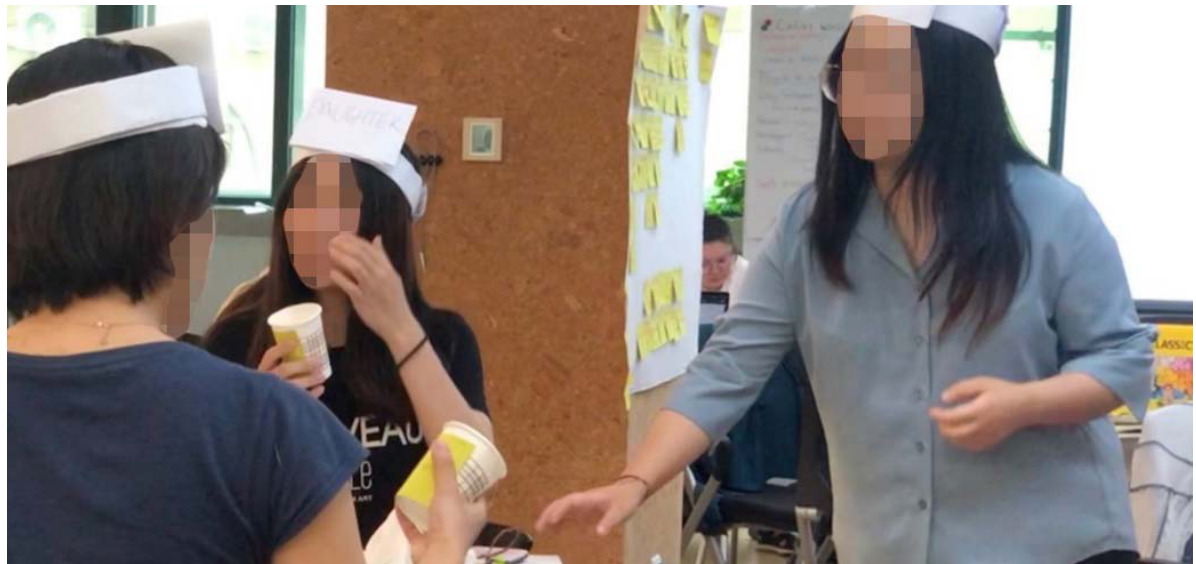
Figure 8. A scenario walkthrough of the Toast! restaurant experience.